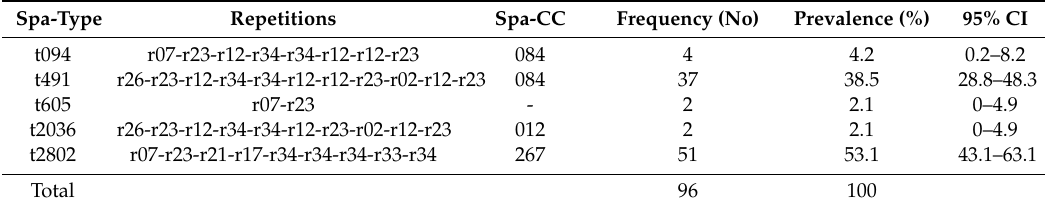
Table 3. Features of clonal lineages: spa-types, spa-repetitions, spa-CCs, frequencies of spa-types, relative prevalence and confidence intervals.